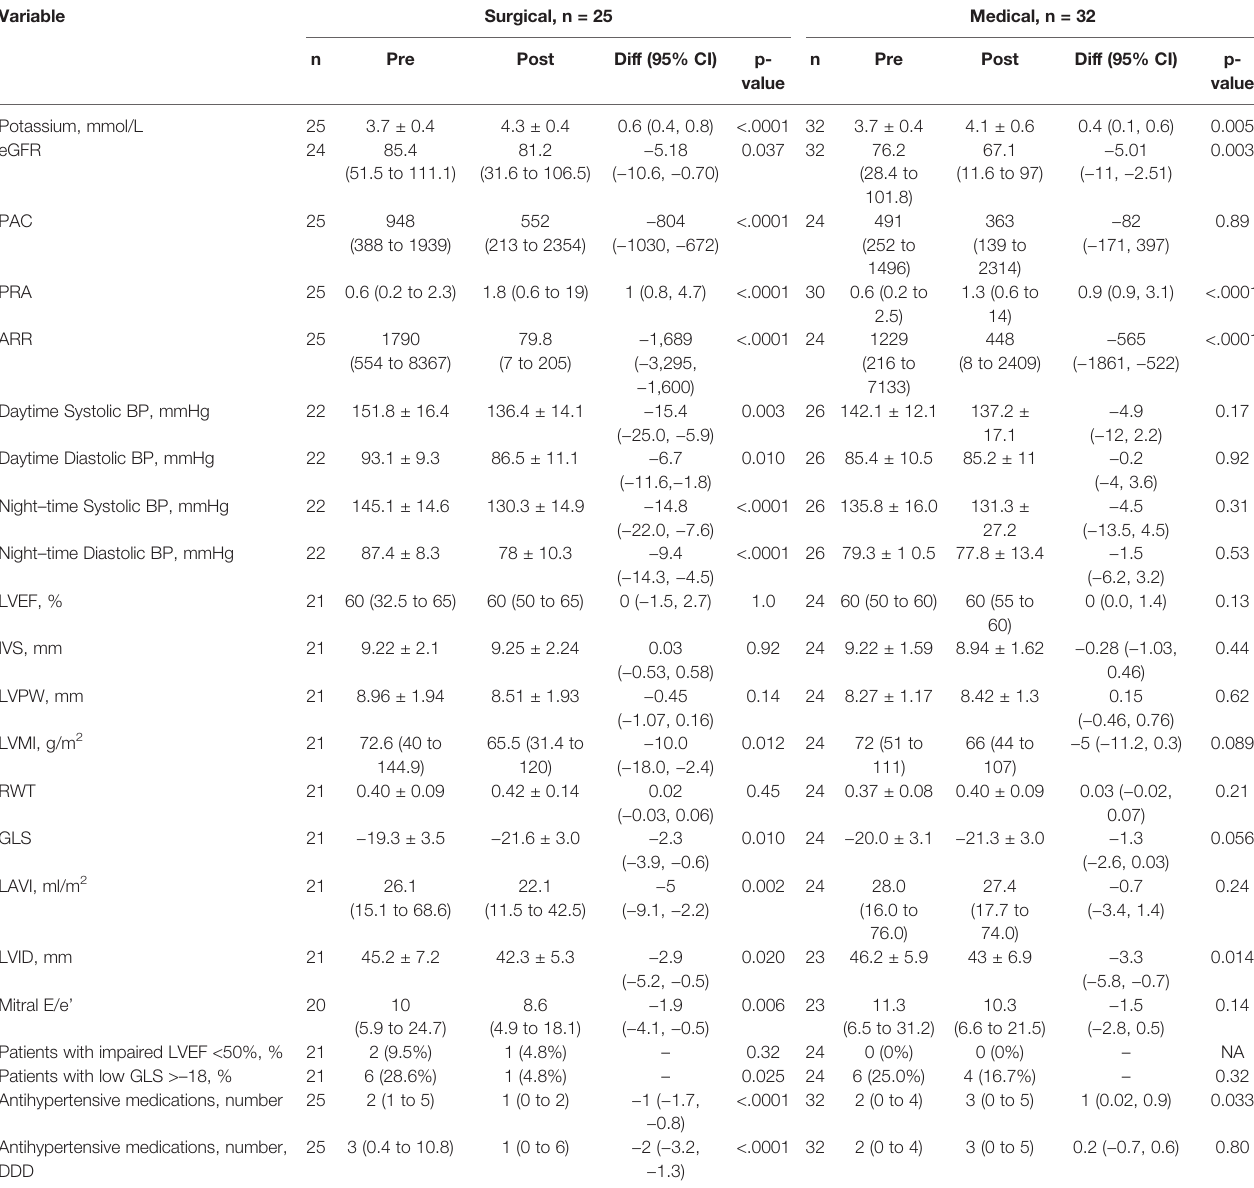
TABLE 1 | Changes in biochemical, 24-h ambulatory blood pressure and echocardiographic parameters from baseline to 12 months after surgical and medical treatment in patients with primary aldosteronism. Variable Surgical, n = 25 Medical, n =